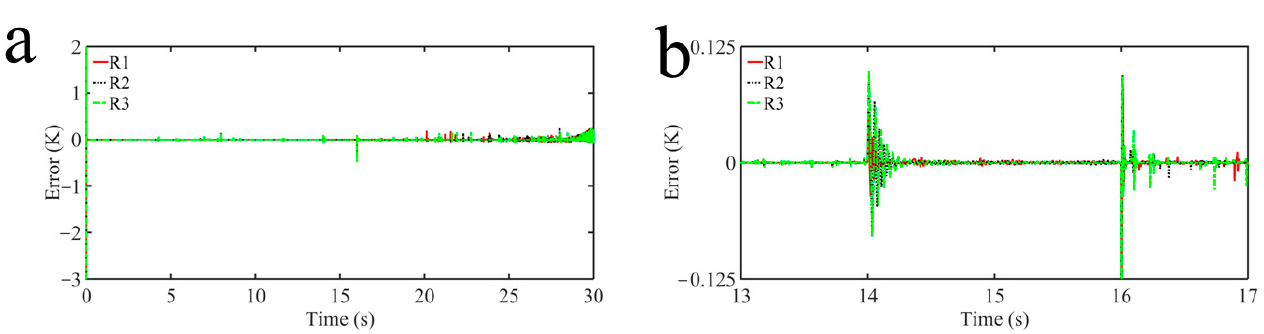
Figure 26. Simulation results with some external disturbances: ( a ) the tracking errors of Wall 0_6 mm for composite controller; ( b ) their partial enlarged figures in details.